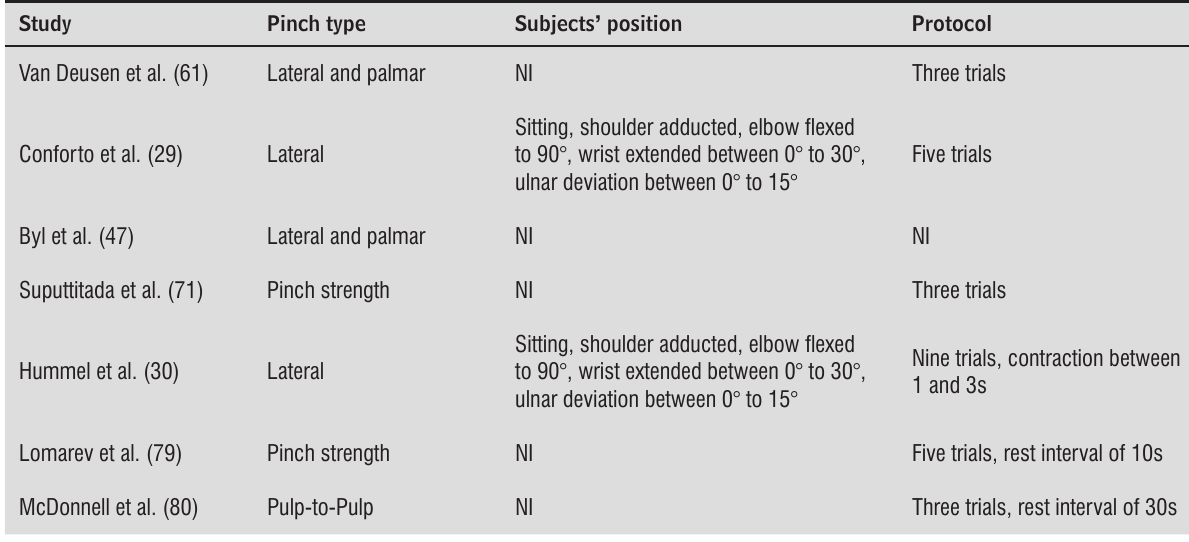
Table 3 - Data extraction of the 15 studies which assessed pinch strength in subjects with stroke with